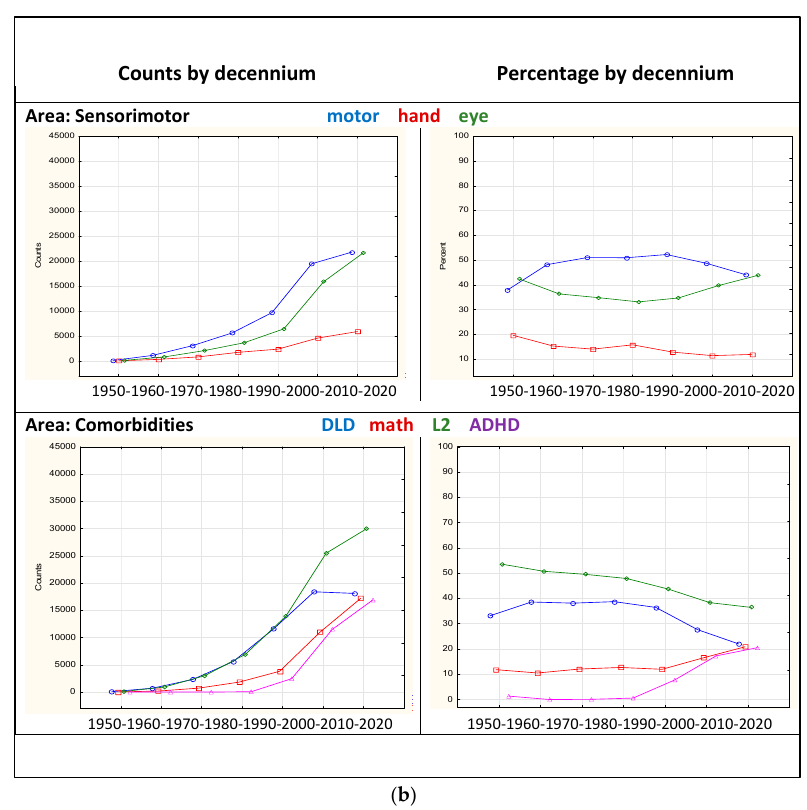
Figure 2. ( a ) Counts and percentage by decennium at the four levels and two areas. ( b ) Counts and percentage by decennium at the two areas.